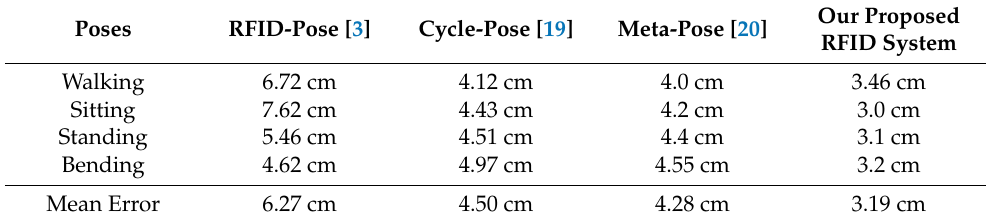
Table 5. Performance comparison with mean estimation error.